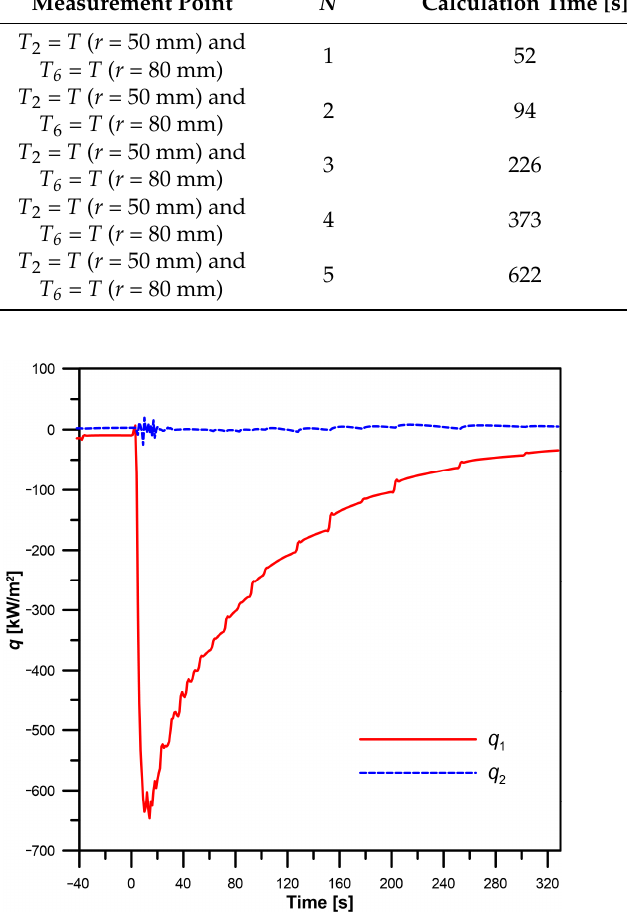
Figure 19. Heat flux on cylinder cooled surface identified by the AMI method.